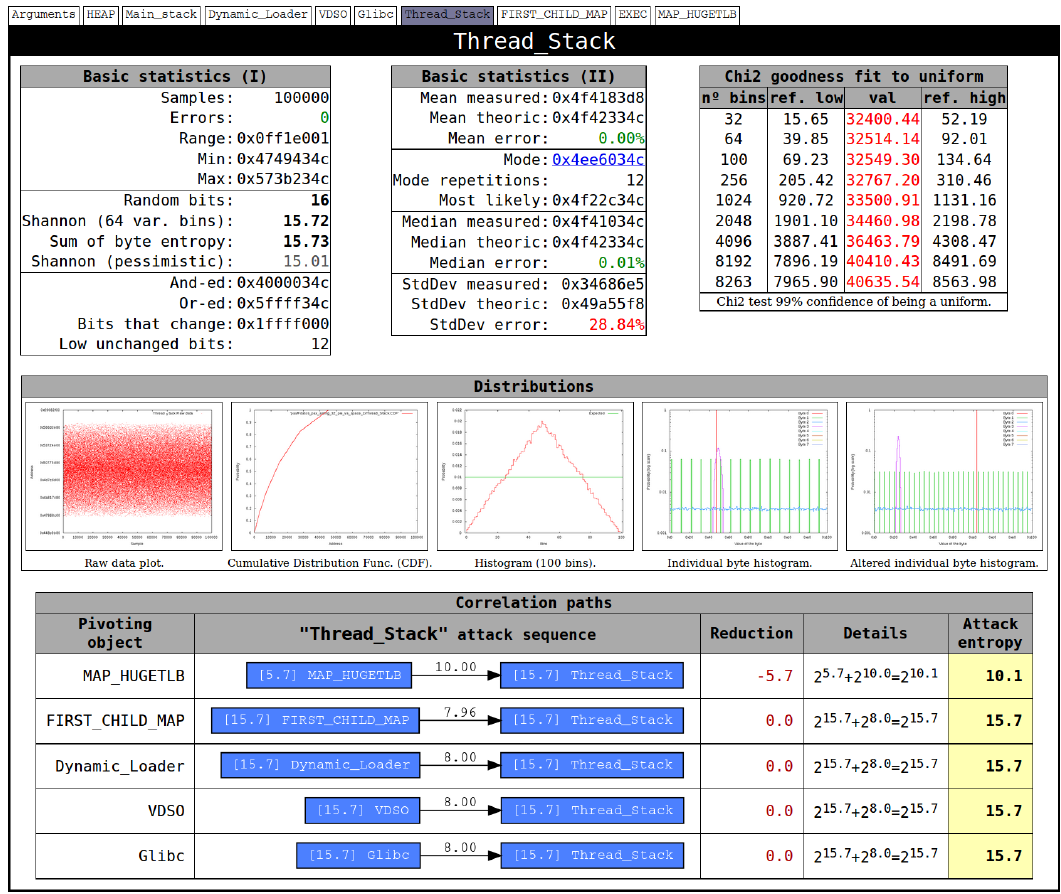
Figure 10. Statistical information produced by ASLRA for the Thread stack on PaX